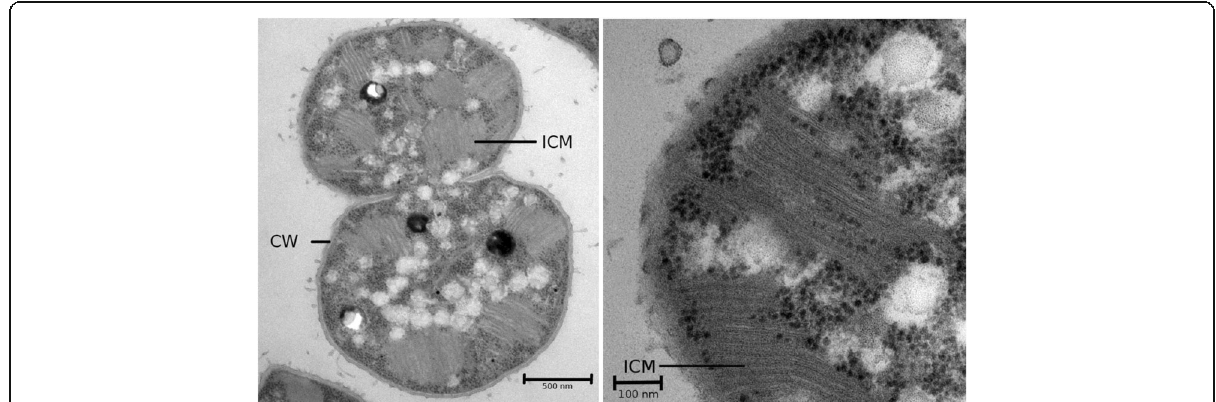
Fig. 1 Transmission electron microscope picture of the strain Methylovulum psychrotolerans HV10-M2. Cell wall (CW) and intracytoplasmatic membrane (ICM) are labelled in the pictures. Scale bars represent 500 (left panel) and 100 (right panel)